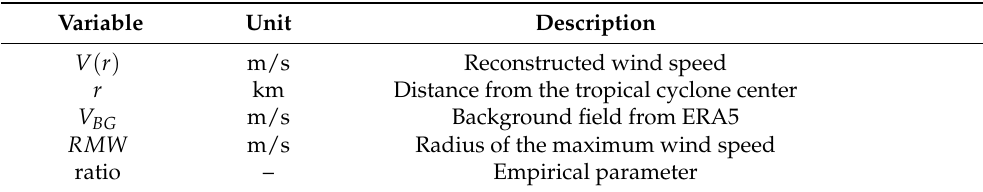
Table 2. Description of each variable used in the proposed method. Variable Unit Description V ( r ) m/s Reconstructed wind speed r km Distance from the tropical cyclone center V BG m/s Background field from ERA5 RMW m/s Radius of the maximum wind speed ratio – Empirical